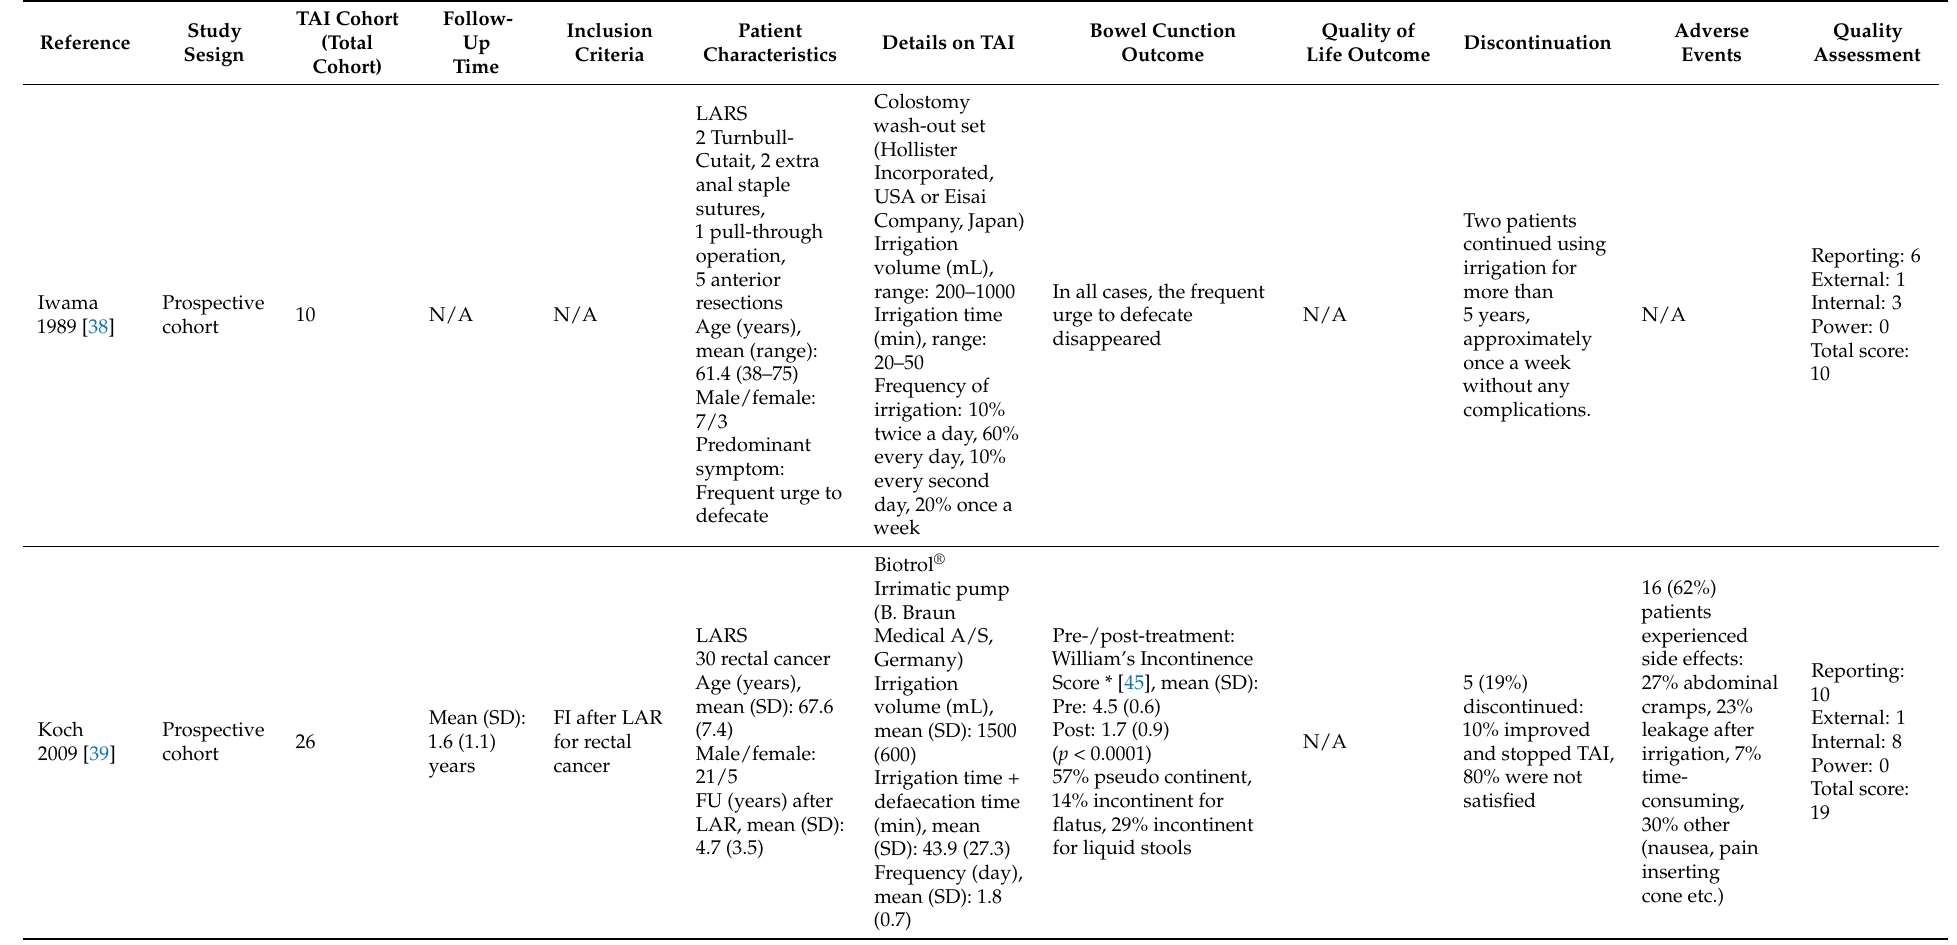
Table 2. Low anterior resection